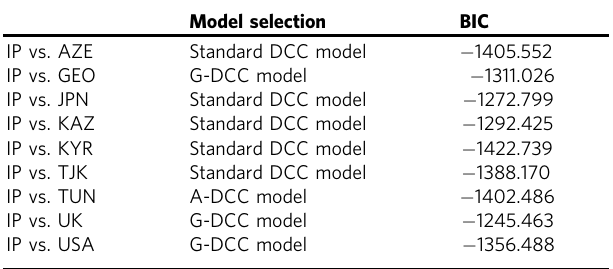
The best- fi tting model is detected by the lowest BIC statistics for each price pairs.